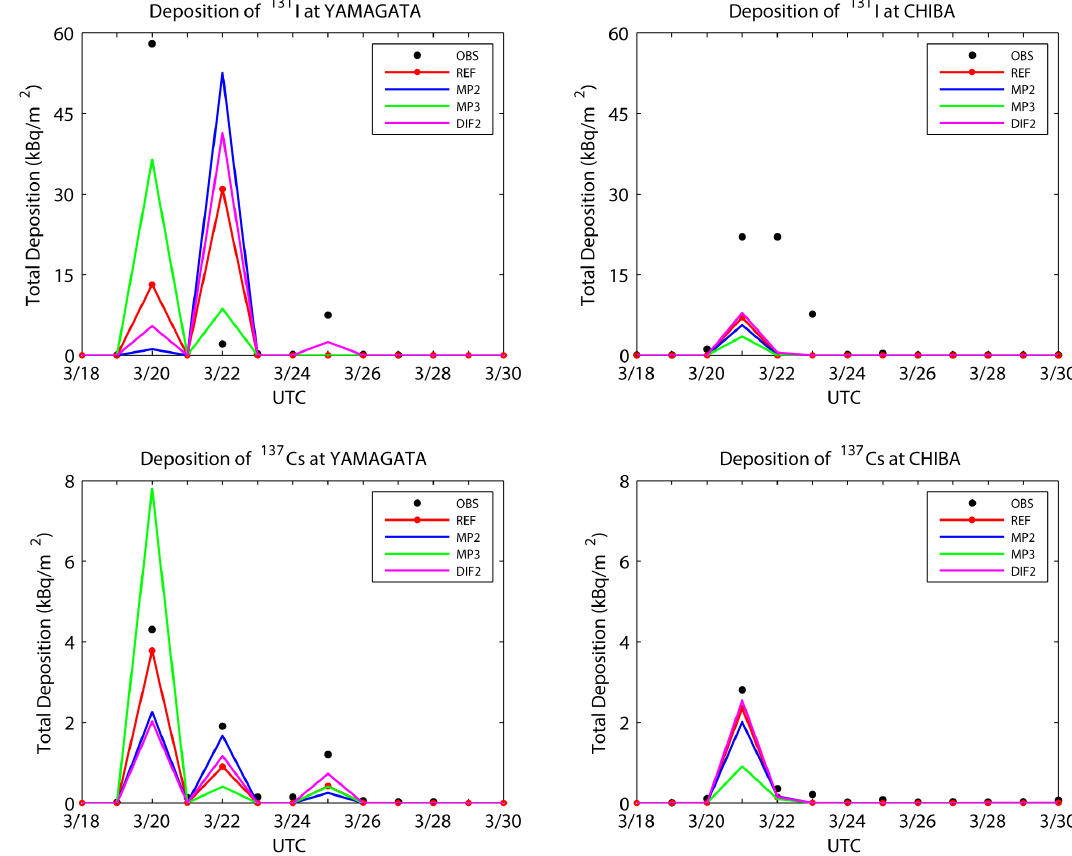
Figure 8. Daily total depositions in station YAMAGATA and CHIBA with different horizontal diffusion and microphysics schemes. Table 4. The PBIAS and PRMSE of total daily depositions of 131 I and 137 Cs with different horizontal diffusion schemes. GR repre- sents the global ranks for PBIAS or PRMSE, and SR represents for the sum of the global ranks. The definition of GR and SR is shown in Sect. 3.1.2. “YA’, “IB”, “TOC”, “GU”, “SA”, “CH” and “TOK” represent the stations “YAMAGATA”, “IBARAKI”, “TOCHIGI”, “GUNMA”, “SAITAMA”, “CHIBA” and “TOKYO”, respectively.